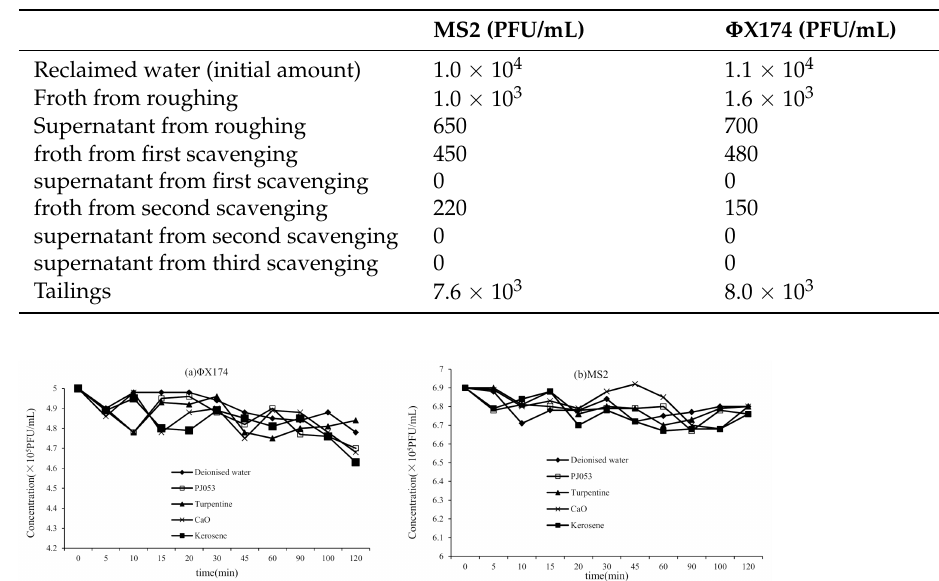
Table 2. Distribution of Φ X174 and MS2 in the flotation test.